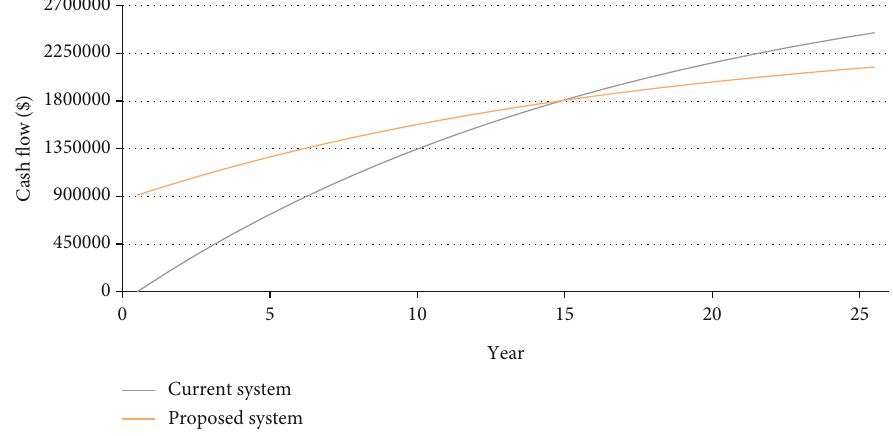
Figure 10: Cumulative cash fl ows over project lifetime for the current and proposed systems for Uganda.